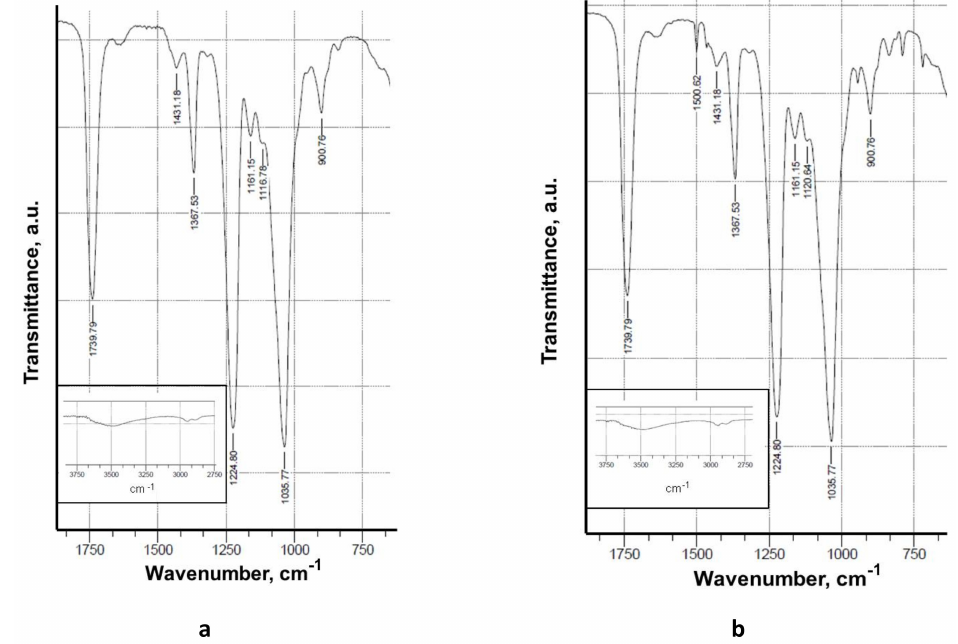
Figure 2. Fourier transform infrared spectroscopy (FTIR) spectra of electrospun membranes of ( a ) CA and ( b ) CA /